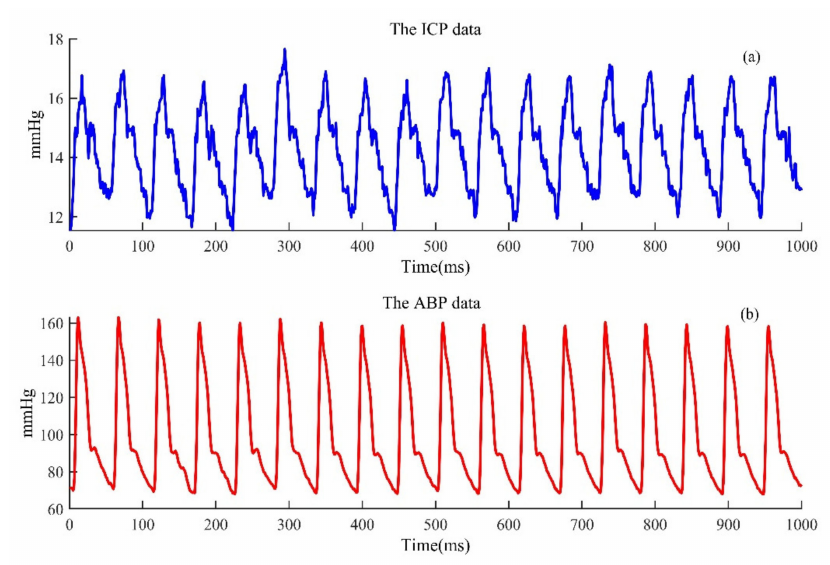
Figure 6. The system output and system input for performance evaluation. ( a ) The waveform of the second system output segment. ( b ) The waveform of the second system input